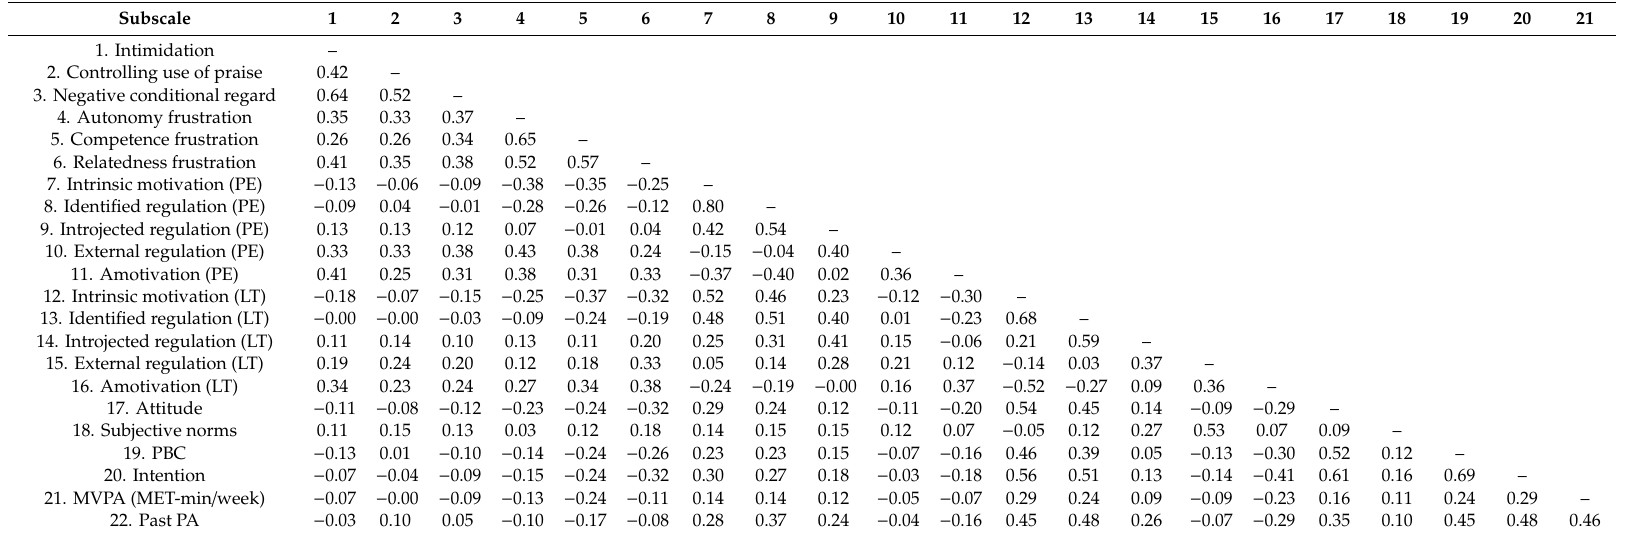
Table 2. Bivariate correlations among all the study